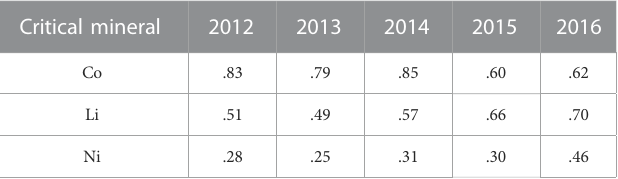
TABLE 9The results of the comprehensive evaluation of the supply risk of cobalt, lithium, and nickel resources in China with a reduced time window. Critical mineral